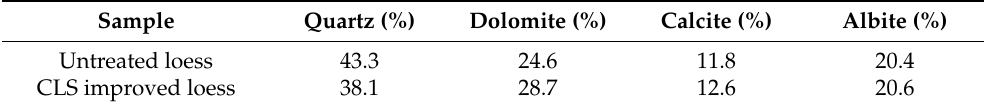
Table 5. Mineral content of samples.